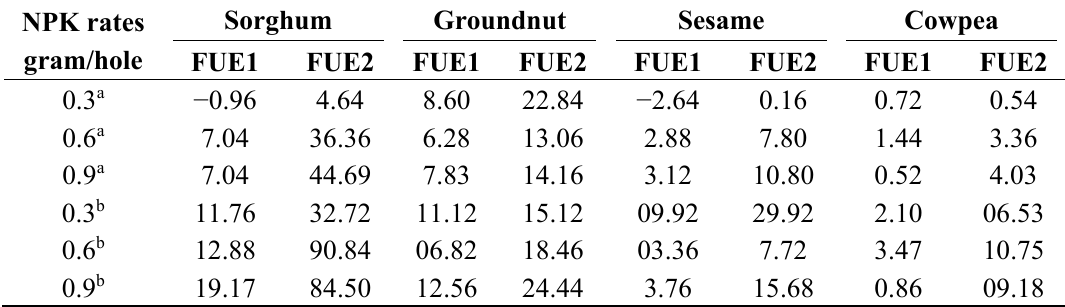
Table 13. Fertilizer use efficiency (FUE kg·kg −1 ) of NPK fertilizer micro-dose rates with and without seed priming (FUE1-grain yield, FUE2-grain + hay yield). a = non-primed seed, b = primed